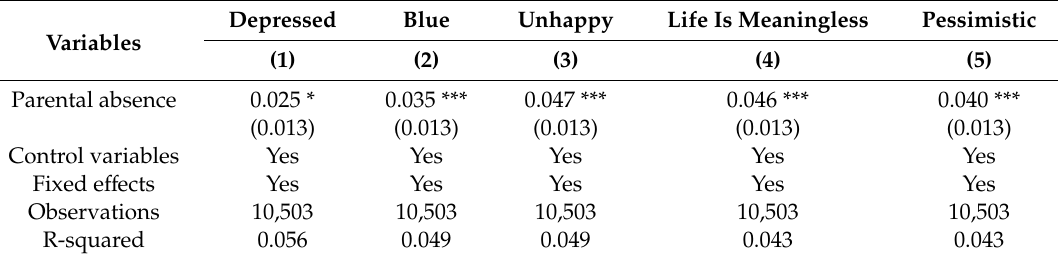
Table 8. The e ff ect of parental absence on mental